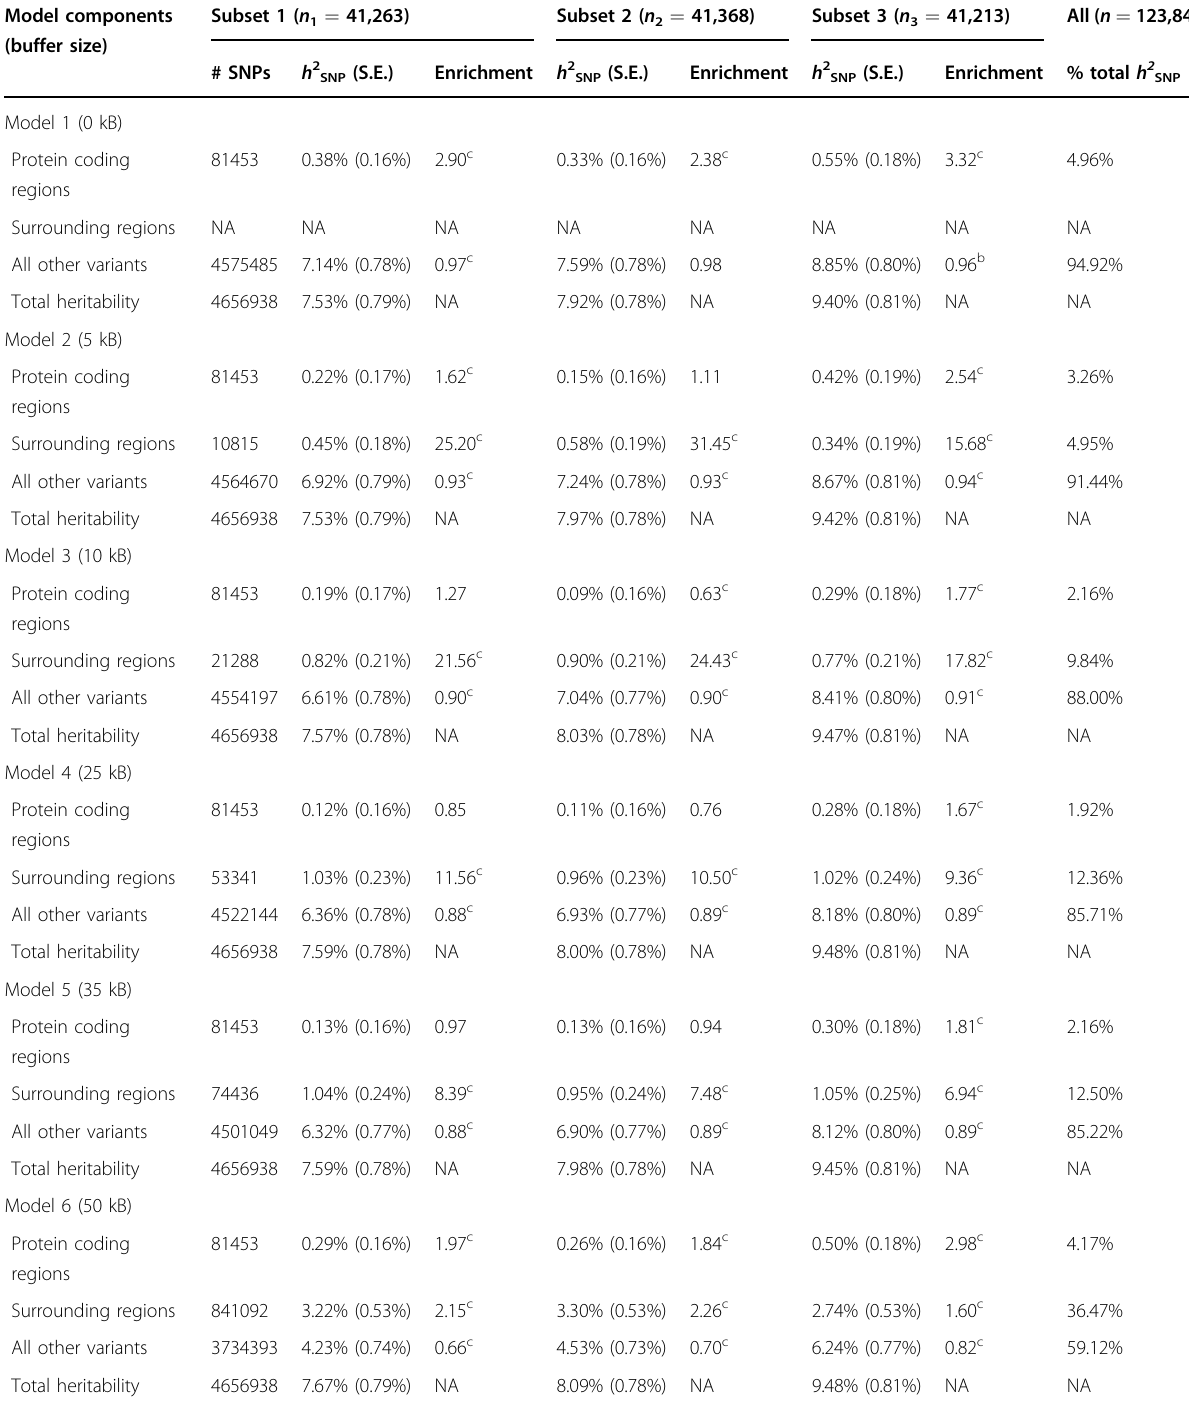
Table 2 Partitioned SNP-heritability ( h 2 SNP ) of Human Tobacco Consumption with Model Organism Nicotine